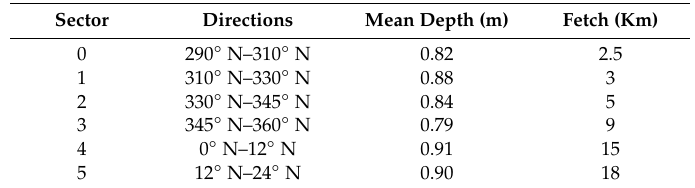
Table 3. Sectors of blowing winds: the second column reports the directions that limit each sector; the mean depth is calculated as an average value weighted on the sector area; the fetch is taken along the mean direction of the